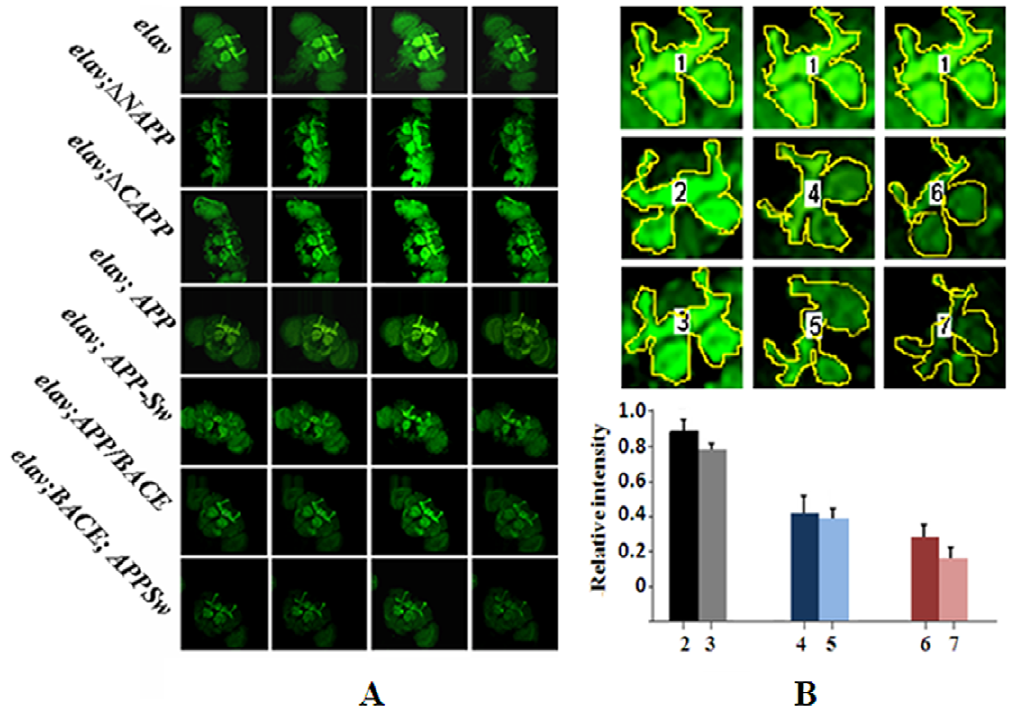
Figure 2. Distribution of GFP–n-synaptobrevin in the Drosophila brain. A ) Optical sections of the brain obtained by confocal microscopy (four brightest sections for each genotype). The fluorescent signal was visualized at a wavelength of l 488 nm. The scanning sections were 2 m m thick. Microphotographs show the brains of 30-day-old flies. B ) Quantitation of relative intensities of GFP–n-synaptobrevin (n-syb-eGFP) in the brain section for transgenic flies with different genotypes: 1.-elav; 2- elav; D NAPP; 3- elav; D CAPP; 4-elav;APP; 5-elav;APPSw; 6-elav;APP/BACE; 7- elav; APPSw/BACE. The pixel intensity in the selected areas was estimated using Image J software and was normalized to the fluorescent signal of elav genotype. Relative intensities are shown as averages 6 SEM. p ,